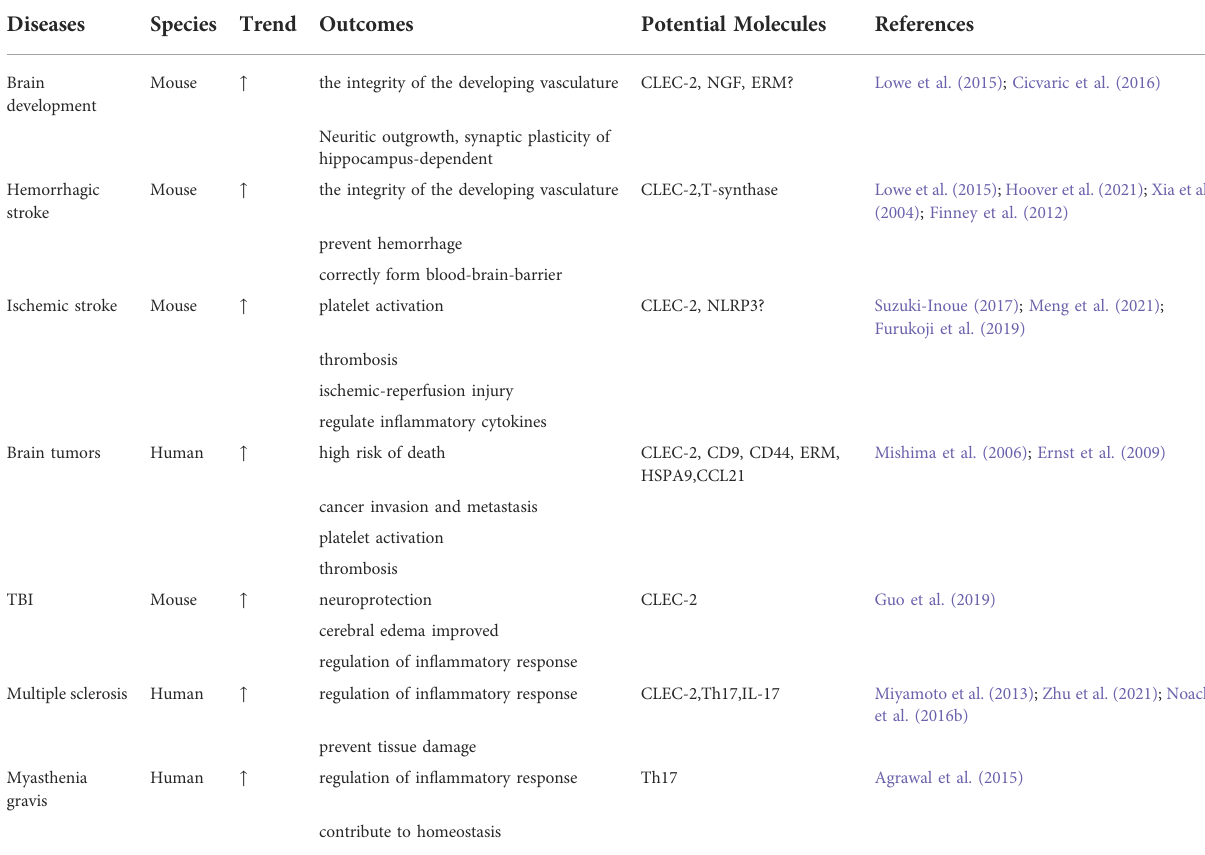
TABLE 1 PDPN in the nervous